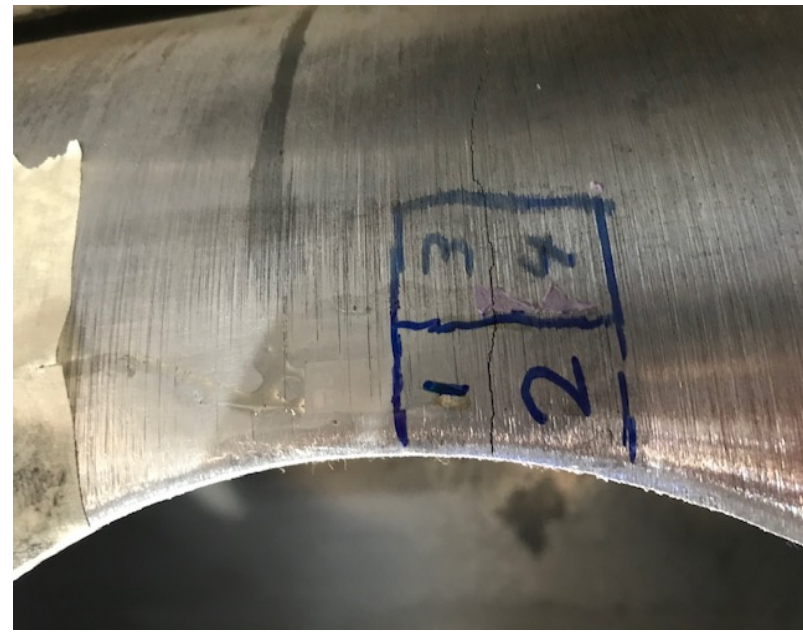
Figure 10. Fatigue crack through pole.